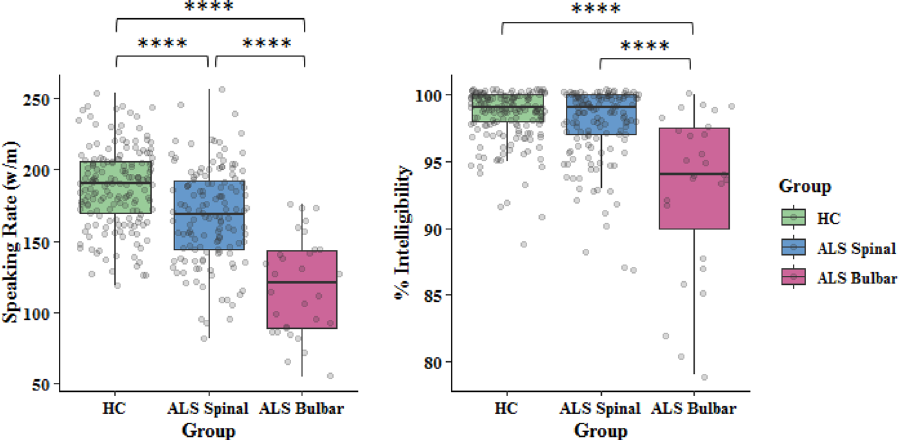
Figure 2. Baseline speaking rate and % intelligibility score in ALS-spinal, and ALS-bulbar groups relative to normative data (HC = healthy controls). ****Represents comparisons that remained significant after Bonferroni adjustment of p-values (p-values less than 0.017 was considered statistically